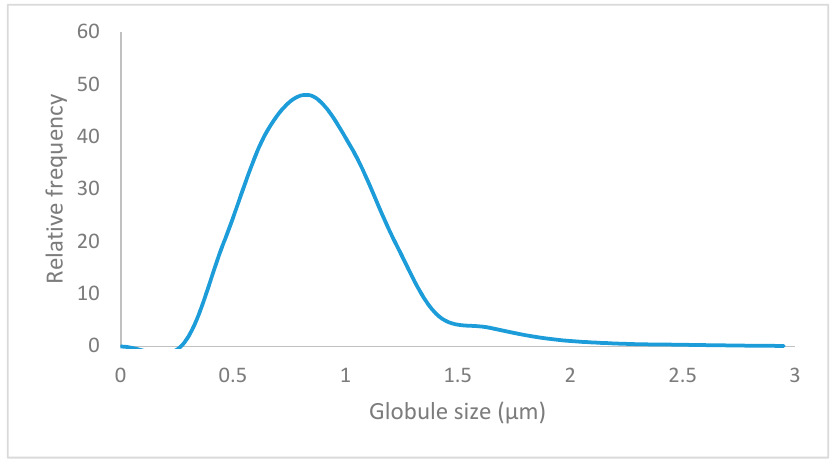
Figure 2. Particle size distribution of water in oil (W/O) emulsion with a 30% IP.